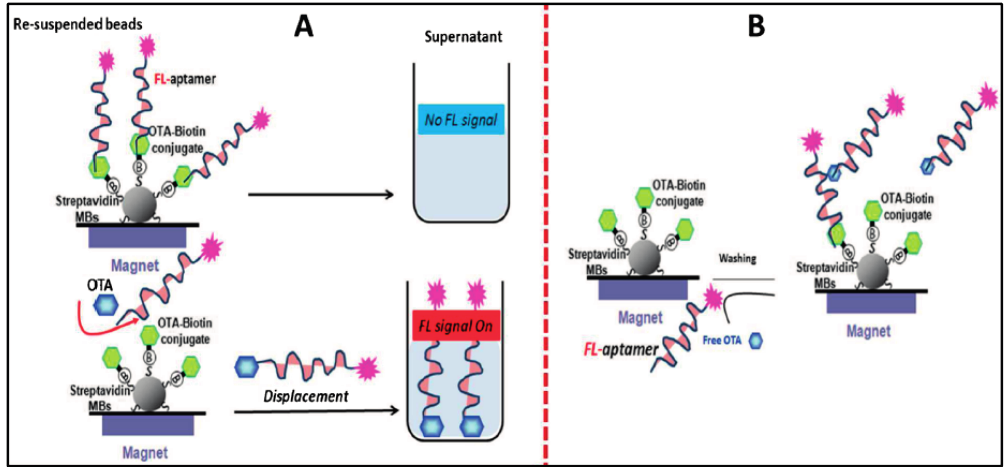
Figure 13. Schematic represents the principle of the assay for the fluorescence